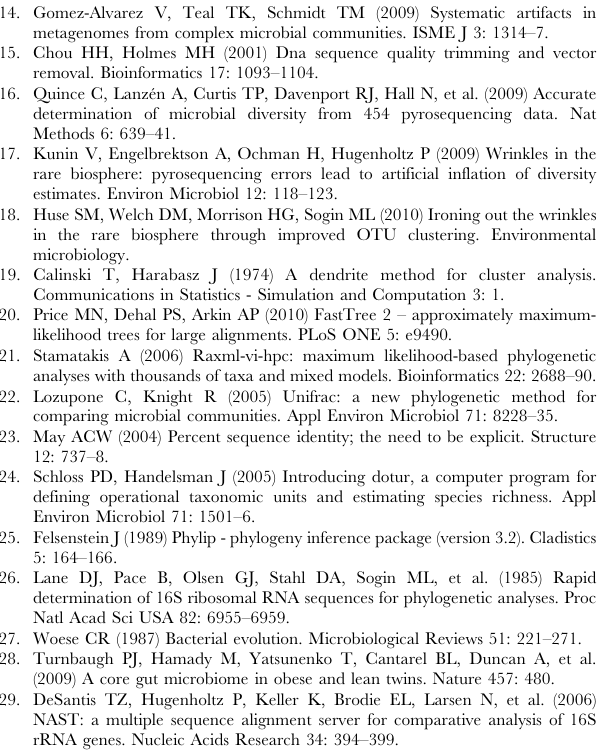
Figure S5 Using splicer, a part of the TORNADO pipeline, to perform hand curation. Dereplicating the hypervariable region significantly reduces the effective number of snippets of sequences one needs to hand curate (4 instead of 6 in this example). In our dataset of around 20,000 sequences, there were only around 200 unique sequence snippets in the hypervariable region varying in length between 1 and 30 bp. (TIFF) Figure S6 Comparison of running times of c-linkage with the running times of Mothur. The two programs were benchmarked on artificial datasets of 1000, 2000, 4000, 6000 and 8000 elements. The sripts used to generate these datasets and run the benchmarks are available at http://tornado.igb.uiuc.edu.